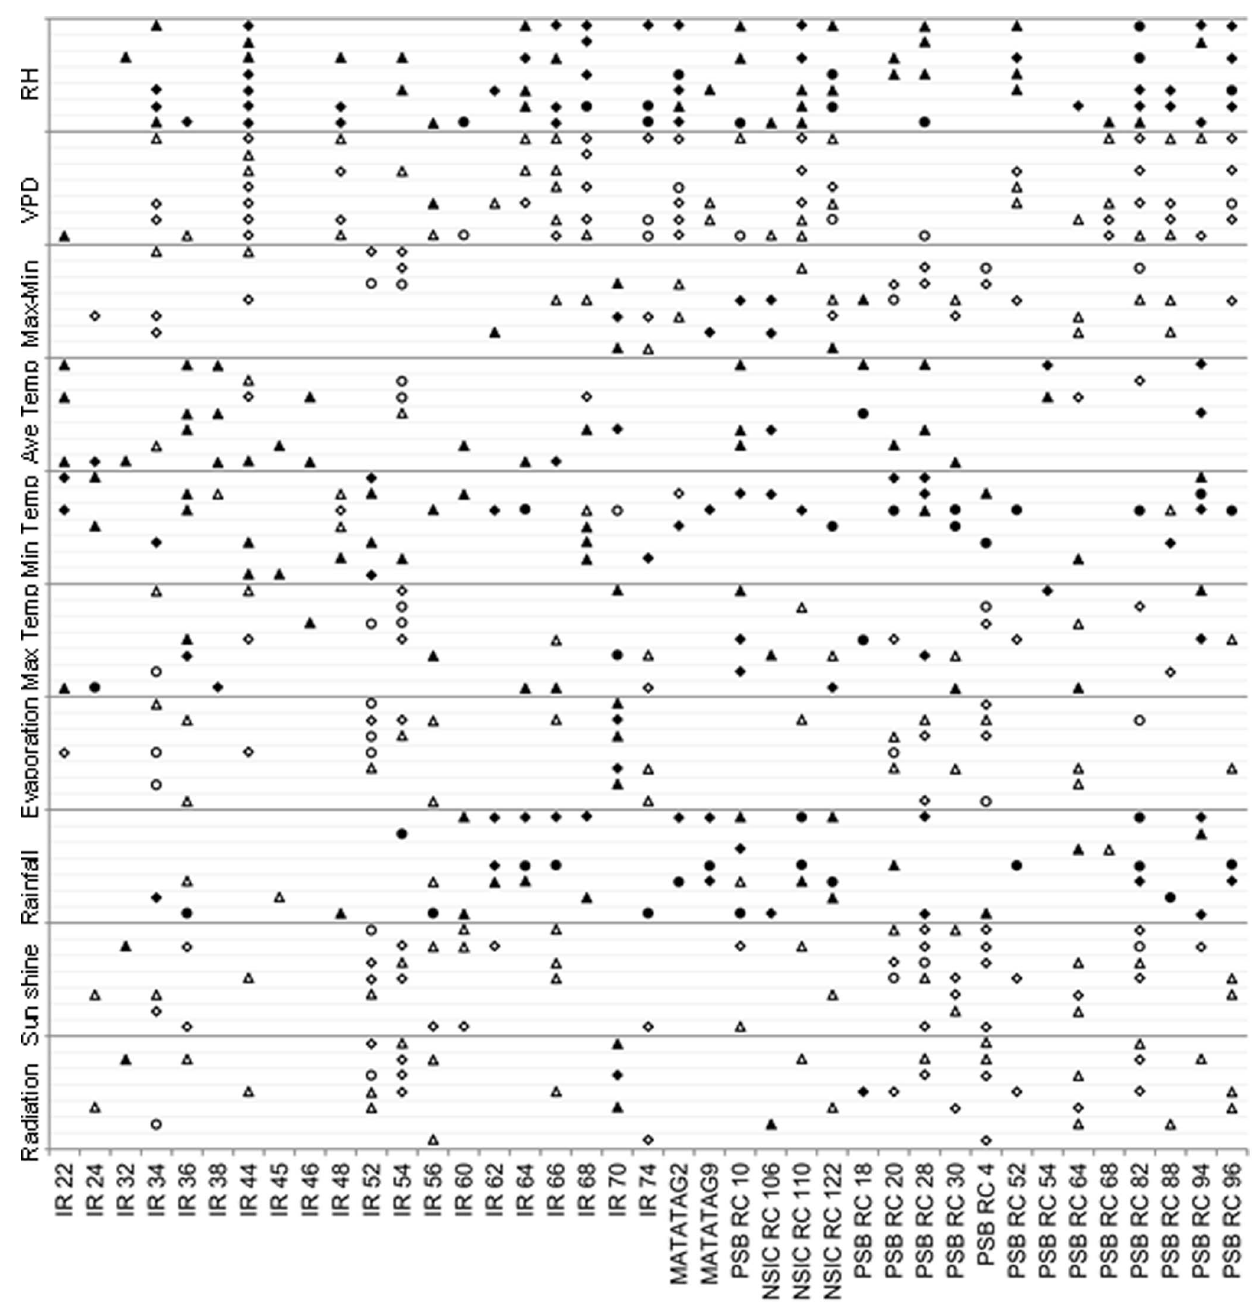
Figure 3. Association between chalkiness and weather parameters on single variety across 8 seasons. Triangles, diamonds and circles represent significance at P , 0.10, P , 0.05 and P , 0.01 respectively. Blank and solid shapes represent negative and positive associations respectively. Gray lines from below to upper for each weather parameter represent 0–5, 6–10, 11–15, 16–20, 21–25, 26–30 and the whole grain filling stage.